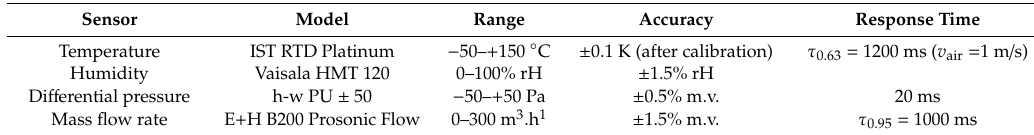
Figure 3. Test facility without insulation. Table 3. Uncertainties of main sensors.